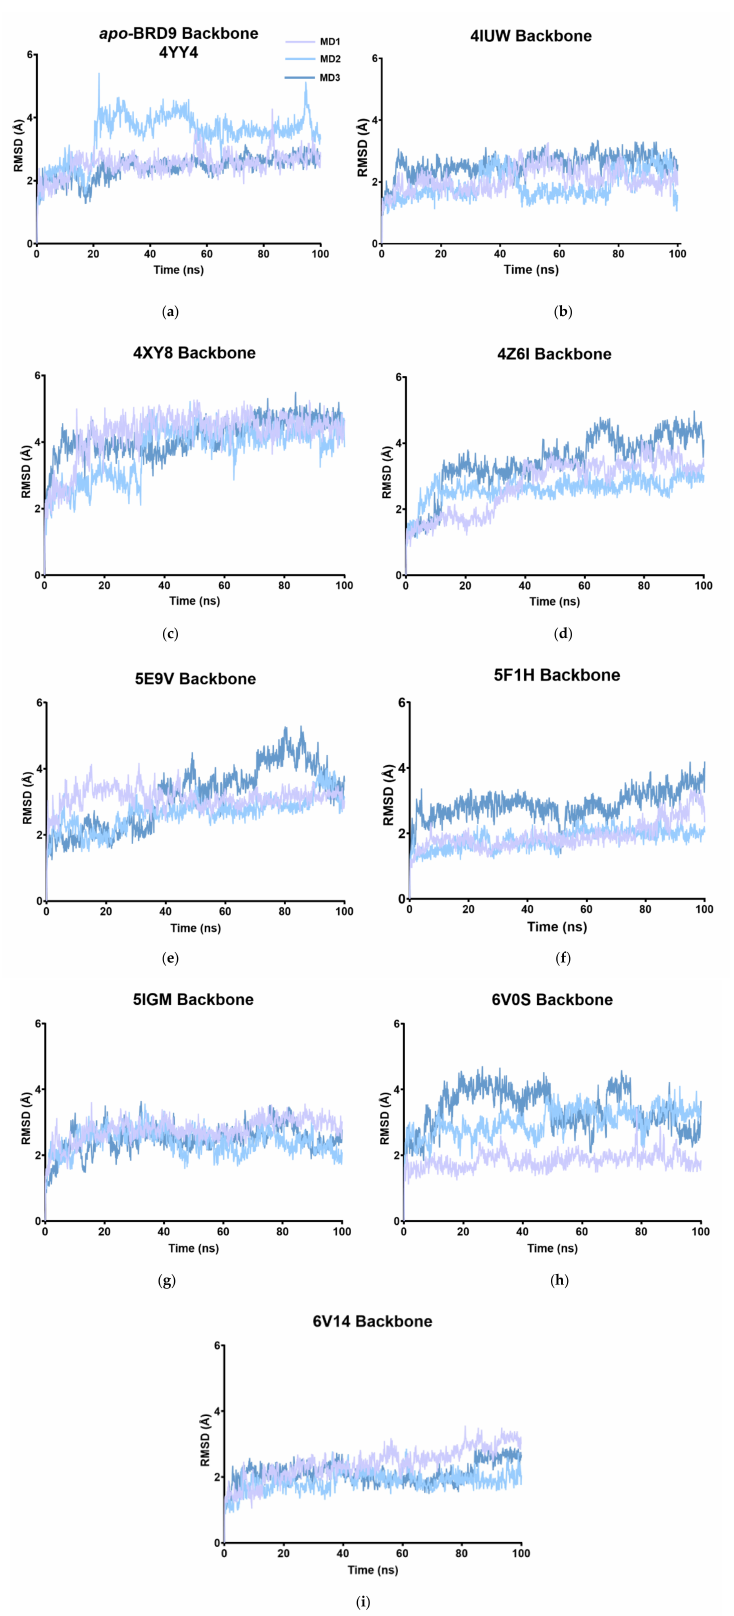
Figure 5. ( a – i ) RMSD of the backbone atoms of the nine systems referred to the original system. Each simulation was run independently three times, specifically for ( a ) apo -BRD9, ( b ) 4UIW, ( c ) 4XYZ, ( d ) 4Z6I, ( e ) 5E9V, ( f ) 5F1H, ( g ) 5IGM, ( h ) 6V0S, ( i )